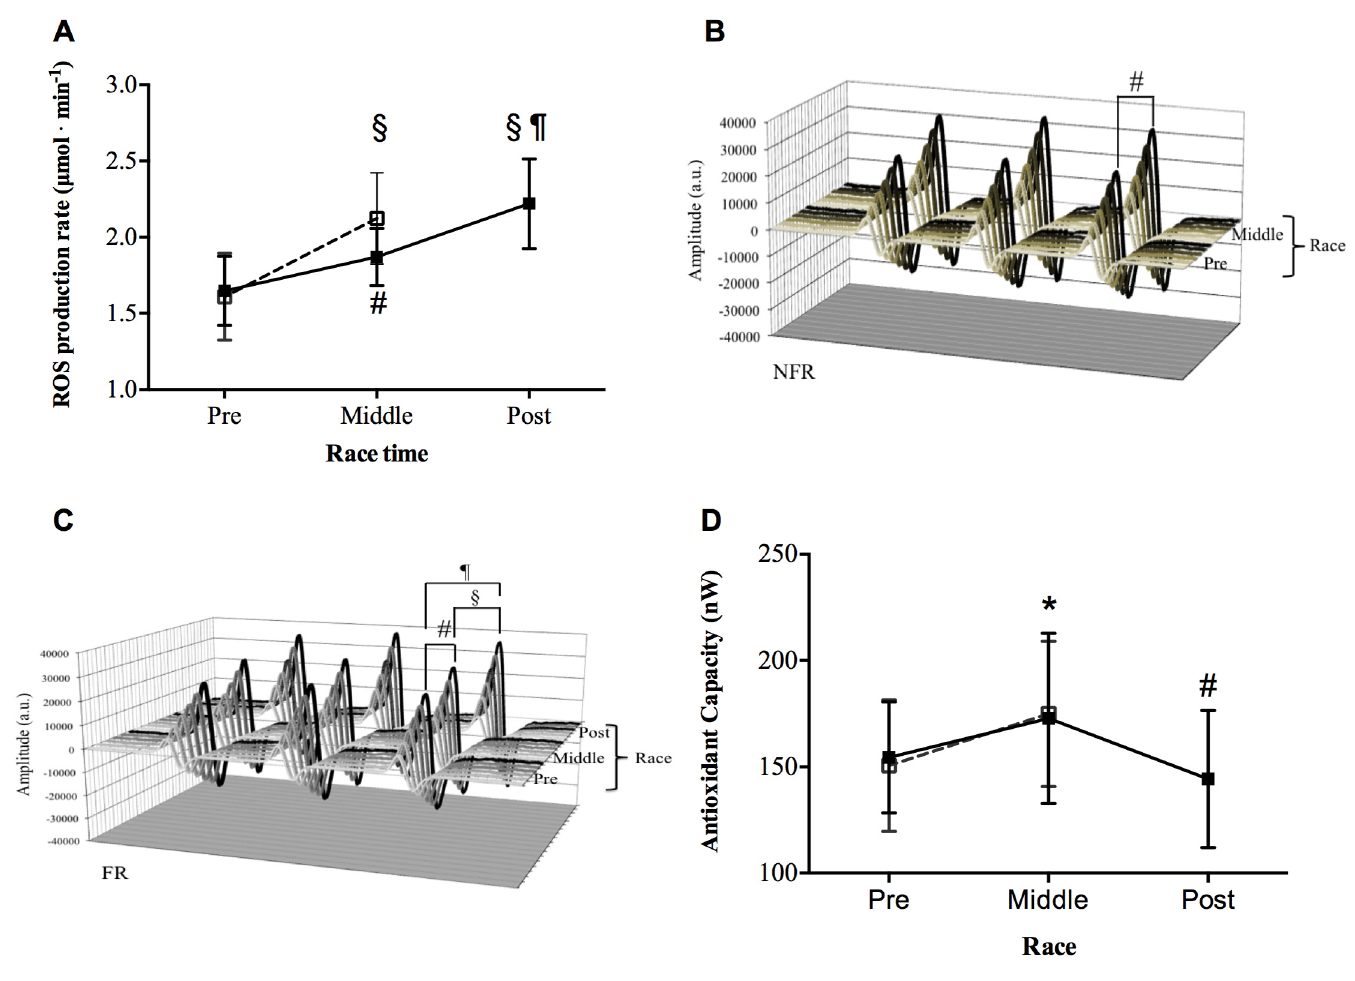
Fig 2. Effects of MUM on ROS Production and Antioxidant Capacity. The data obtained in the two groups of athletes are shown: FR (closed symbols), NFR (open symbols). Results are expressed as mean ± SD. Time course of: A) ROS production rate ( μ mol.min -1 ) detected by EPR technique before (Pre), at Middle and immediately Post race. Changes over time were significant compared to pre competition in both groups (# symbol, P < 0.01 and § symbol, P < 0.001); in the FR group: Pre with respect to Post-Run P < 0.0001 (¶ symbol); Middle with respect to Post-Race P < 0.001 (§ symbol). Examples of the stacked plots of the EPR spectra recorded: B) at Pre, and Middle Race collected from a NFR subject and C) at Pre, Middle and Post-Race in a FR subject. In each panel the increase of the signal amplitude (a. u.) is shown. The differences between Pre vs Midlle-Race (# symbol, P < 0.01), Middle versus Post-Race (§ symbol, P < 0.001) and Pre versus Post-Race (¶ symbol, P < 0.0001) are indicated. D) Time course of the antioxidant capacity (nW) before (Pre), at Middle and immediately Post-Race. In the FR group, the changes over time were significantly different ( * symbol, P < 0.05) at Middle with respect to Post-Race and (# symbol; P < 0.01;) with respect to Pre-Race. In Panels A and D, the lines are drawn to guide the eye.